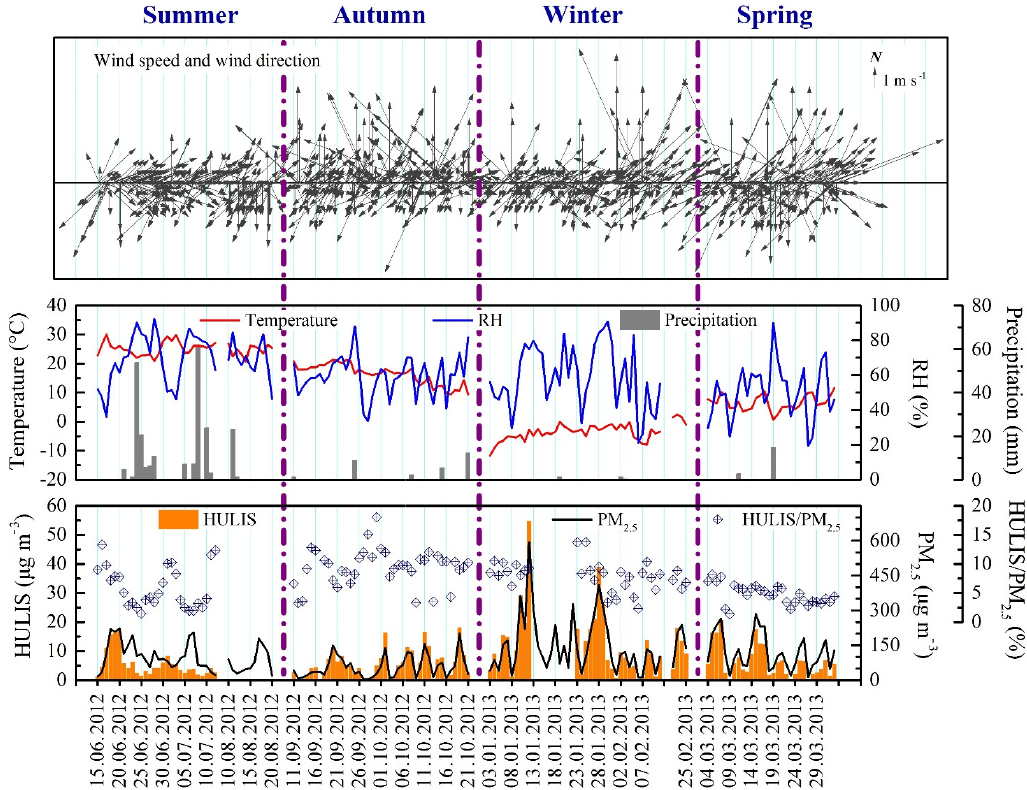
Figure 1. Time series of meteorological data (wind speed, wind direction, temperature, relative humidity, and precipitation), HULIS, PM 2 . 5 , and HULIS / PM 2 . 5 for the sampling